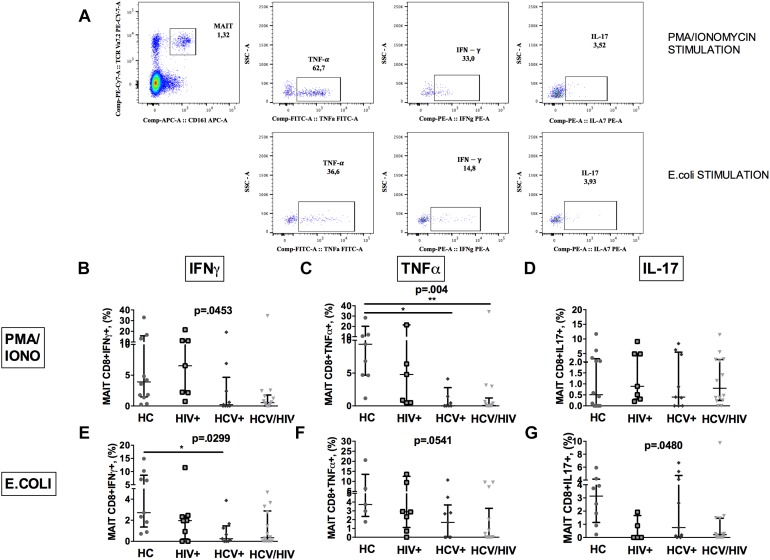
Vα7.2+CD161++CD8+ cytokine production following ex vivo stimulation. The lines indicate the significant comparison between two groups. ∗ indicates the p-value for each pair of groups: ∗
p < 0.05, ∗∗
p < 0.01, ∗∗∗
p < 0.001. (A) Flow cytometry gating strategy for cytokine production. (B) Stimulation with PMA/ionomycin resulted in significantly lower production of IFNγ (HC: 3.57%, HIV+: 4.39%, HCV+: 0.22%, HCV+/HIV+: 0.54%, p = 0.045) in virally infected, particularly co-infected individuals, compared to HC. (C) Co-infected individuals showed the lowest TNFα release after PMA/ionomycin (HC: 8.11%, HIV+: 4.39%, HCV+: 0.02%, HCV+/HIV+: 0.07%, p = 0.004). (D) Similar production of IL-17 between the study groups following PMA/ionomycin exposure (HC: 0.43%, HIV+: 0.70%, HCV+: 0.40%, HCV+/HIV+: 0.80%, p = 0.883). (E) Following E. coli stimulation, MAITs of infected patients produced inadequate quantity of IFNγ (HC: 2.72%, HIV+: 1.96%, HCV+: 0.25%, HCV+/HIV+: 0.33%, p = 0.025). (F) Virally infected patients showed lower TNFα production upon bacterial challenge (HC: 3.73%; HIV+: 0.17%, HCV+: 1.69%, HCV+/HIV+: 0.01%, p = 0.054) (G)
E. coli exposure resulted in lower IL-17 production in virally infected patients vs. HC (HC: 3.14%, HIV+: 0%, HCV+: 0.75%, HCV+/HIV+: 0.21%, p = 0.048).